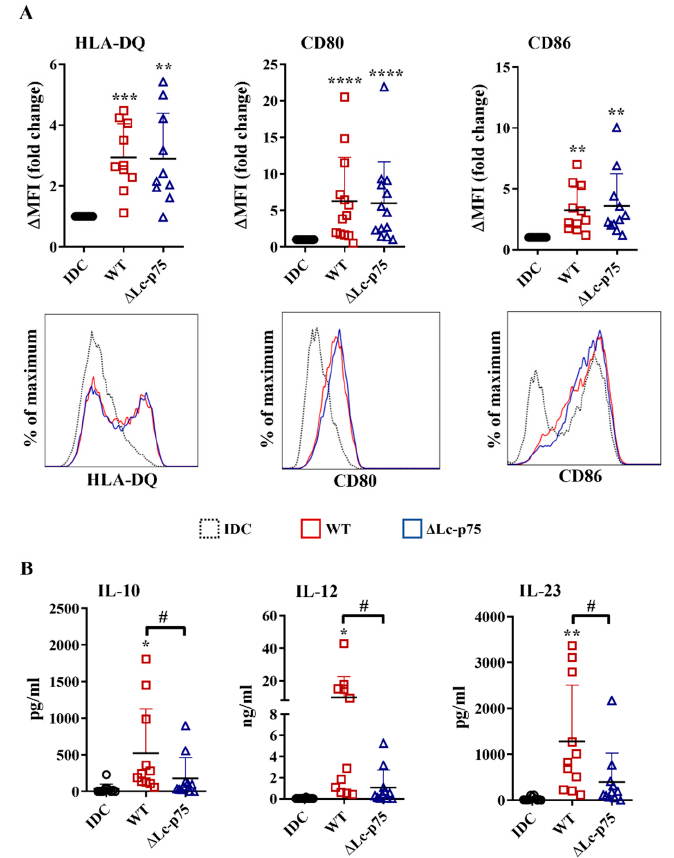
Figure 2. Deletion of Lc-p75 PGH in L. casei BL23 does not affect the antigen-presenting and costimu- latory capacity of bacteria-exposed moDCs but causes decreased T-cell-polarizing cytokine secretion by these cells. Five-day moDCs were stimulated with live wild-type (WT) L. casei BL23 and ∆ Lc-p75 mutant strain at a ratio of 1:4 for 24 h. The expression of HLA-DQ, as well as costimulatory CD80 and CD86 molecules ( A ), was measured using flow cytometry. The fold change of the median fluorescent intensities ( Δ MFI) compared to the control cells (IDC) was calculated from 10–13 inde- pendent experiments ±SD. Histogram overlays show one representative experiment. The concen- trations of T-cell-polarizing IL-10, IL-12, and IL-23 cytokines ( B ) were measured using ELISA from the supernatant of activated moDCs and control, nontreated cells (IDC). Figures show the mean of 10–11 independent experiments ±SD. Each dot represents one donor. Student’s paired two-tailed t - test was used in the statistical analysis, with significance defined as * p < 0.05, ** p < 0.01, *** p < 0.001 and ****p < 0.0001 compared to IDC; and # p < 0.05 between WT and Δ Lc-p75. In addition to inflammatory cytokine and chemokine secretion, DCs also secrete sol- uble mediators to shape the differentiation of various T cell subsets. Therefore, we meas- ured the T-cell-polarizing IL-10, IL-12, and IL-23 production by moDCs after a 24 h acti- vation with L. casei strains. Importantly, WT L. casei induced more robust IL-10, IL-12, and IL-23 secretion by moDCs than their PGH defective counterpart (Figure 2B).